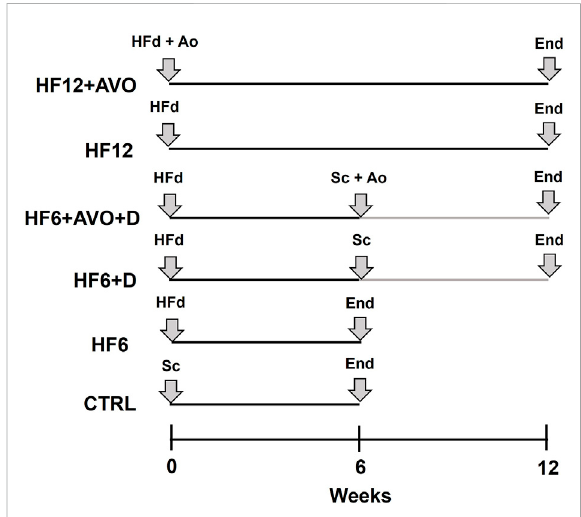
FIGURE 1 Graphical description of the time course of the experimental diets. CTRL: rats were fed for 6 weeks with standard chow; HF6: the HF diet was given for 6 weeks; HF12: the HF diet was given for 12 weeks; HF6+D: the HF diet was given for 6 weeks and then, it was substituted by standard chow and given for additional 6 weeks; HF6+AVO + D: the HF diet was given for 6 weeks and then, it was substituted by standard chow plus avocado oil and given for additional 6 weeks; HF12 + AVO: the HF12 diet was given for 12 weeks supplemented with avocado oil. Sc: standard chow; End: end of the experimental period at which the rats were sacri fi ced; HFd: high fat - high fructose diet; Ao: avocado